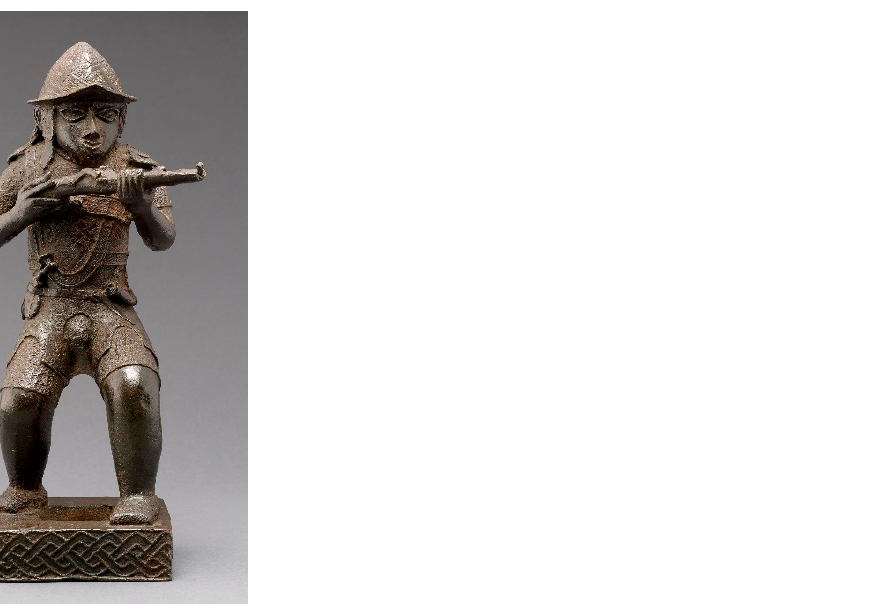
Figure 8. Cast bronze figure of a Portuguese soldier from the 17th century in Benin City, Edo State, which was located in modern-day Nigeria. Statues such as this one were often kept on royal altars or displayed on the roof of the royal place in Benin City. Portuguese slave traders brought luxury goods from the sea, and were seen to be connected to Olokun, the god of the sea. Image courtesy of the British Museum.